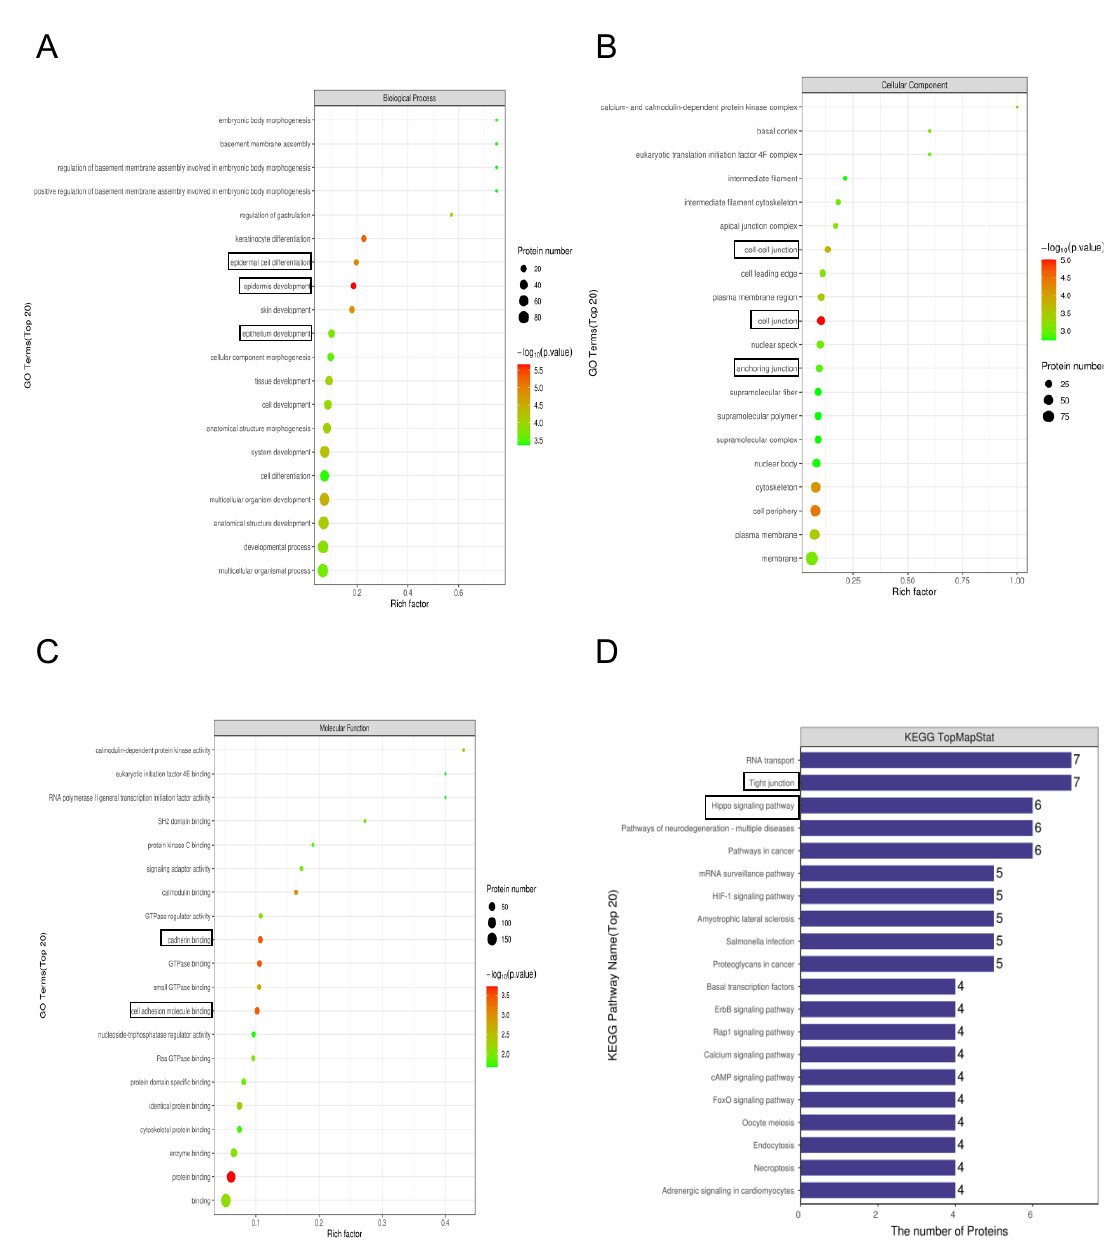
Figure 3. Functional characteristics and KEGG analysis of DEPs. ( A ) The biological processes analysis of DEPs. ( B ) The cellular components analysis of DEPs. ( C ) The molecular functions analysis of DEPs. ( D ) KEGG pathway enrichment analysis of DEPs.